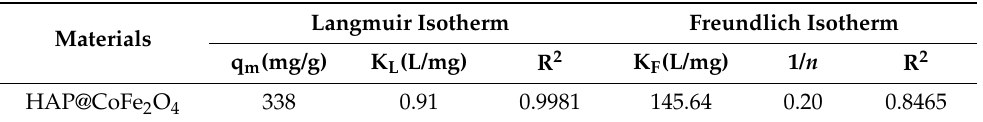
Table 1. Freundlich and Langmuir isotherm constants for the U(VI) adsorption onto the